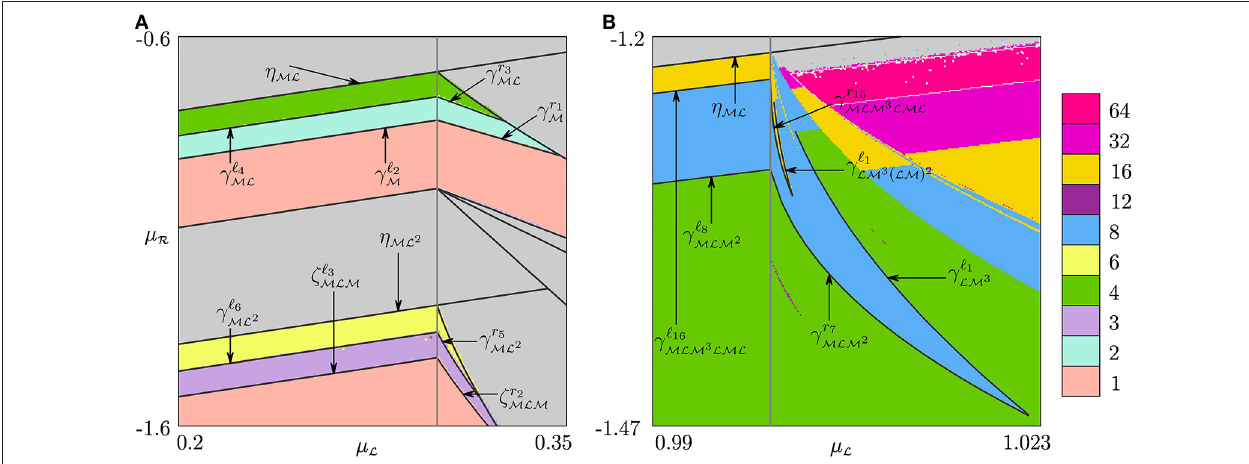
FIGURE 6 | Bifurcation structures associated with D 0 -prolongations of the boundaries of the chaoticity regions belonging to the STM structure in D 1 . Parameters: (A) a L = 0.5, a R = 1.3, d L = 0, d R = 0.3. (B) a L = 0.9, a R = 1.1, d L = 0, d R = 1.